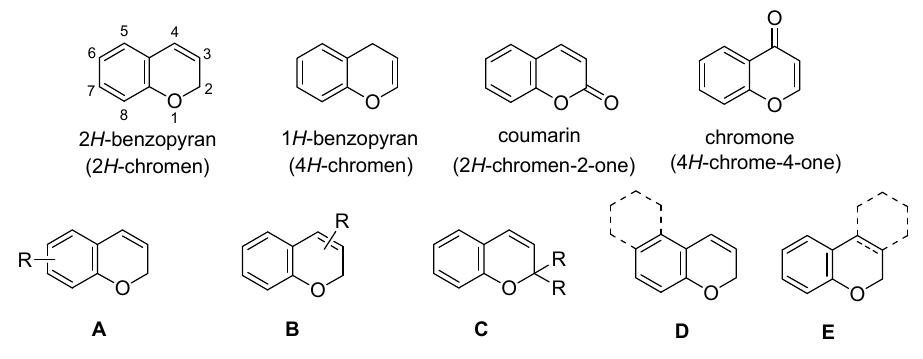
Figure 2. The core structures of